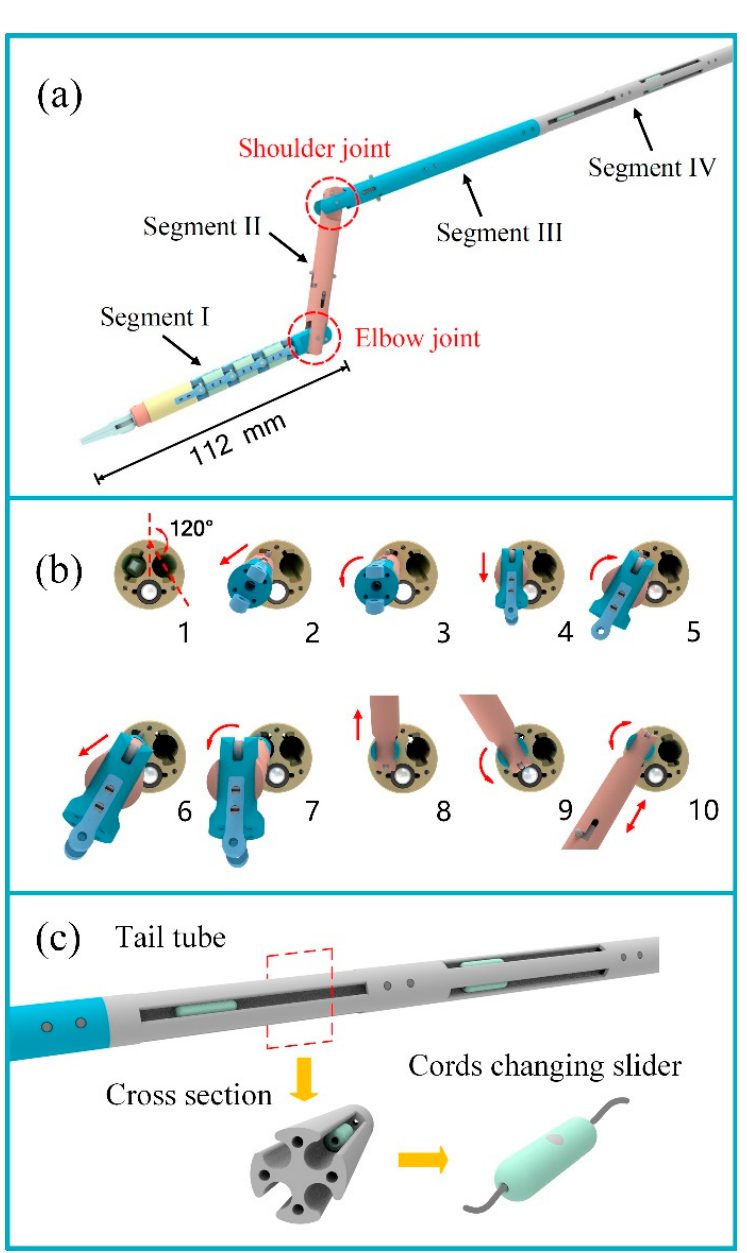
Figure 2. The design of the instrument tube. ( a ) structure diagram of the surgical instrument; ( b ) unfolding process of the articulated arm; ( c ) schematic diagram of the tail tube structure. Table 1. The unfolding process of the articulated arm.